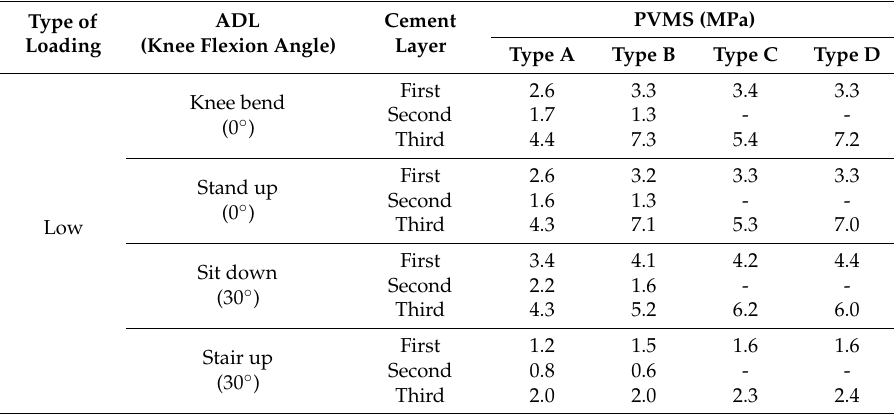
Table 3. PVMS within bone